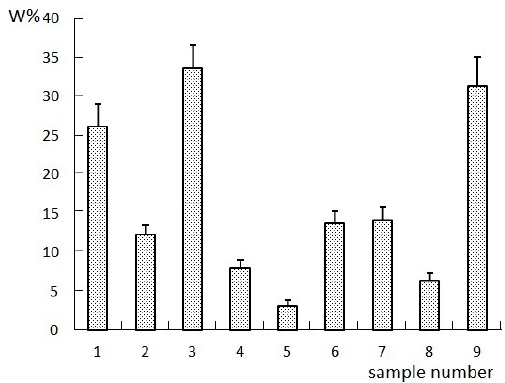
Figure 1. Results of W% (the cell proliferation inhibition rate) in vitro tumor inhibition experiments in each group.